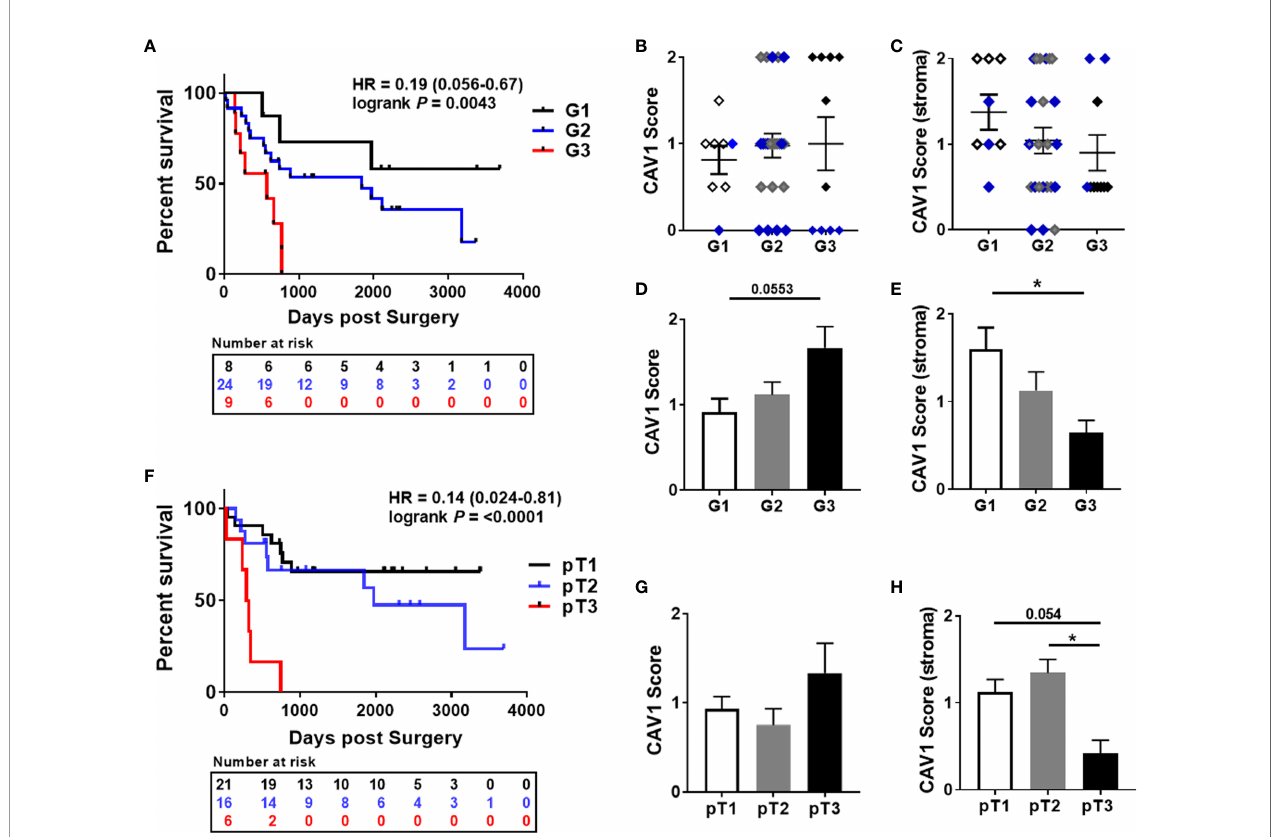
FIGURE 5 | Prognostic impacts of epithelial-stromal CAV1 expressions in penile cancer in relation to the tumor grade. (A) Overall survival curves for penile cancer patients according to the tumor grade (low-grade/G1 n=8; moderate/G2 n=23; high grade/G3 n=9). HR and log-rank P (G1 versus G3) are indicated. HR=0.46 (0.17-1.24), log-rank P=0.20 (G1 versus G2); HR=0.35 (0.12-1.08), log-rank P = 0.010 (G2 versus G3). (B) According to the tumor grade, the CAV1 immunoreactivity score for low (0-0.5), moderate (>0.5-1.5), and high (>1.5-2) CAV1 expression levels of respective tumor cells was estimated. (C) Further on, the CAV1 immunoreactivities of the tumor stroma were determined in correlation with the tumor grades. P16-positivities are indicated by the blue color. According to the tumor grade, CAV1 scores only of the p16-negative tumor epithelium (D) and of the tumor stroma (E) were analyzed. * P<0.05 by one-way ANOVA followed by post-hoc Dunnett ’ s multiple comparisons test. (F) Overall survival curves for penile cancer patients according to the tumor stage (pT1 n=21; pT2 n=16; pT3 n=6). HR and log-rank P (pT1 versus pT3) are indicated. HR=0.23 (0.053-1.01), log-rank P=0.20 (pT2 versus pT3). CAV1 immunoreactivities of the tumor epithelium (G) and of the stroma( H ) were determined in correlation with the tumor stages. *P<0.05, by one-way ANOVA followed by post-hoc Tukey ’ s multiple comparisons